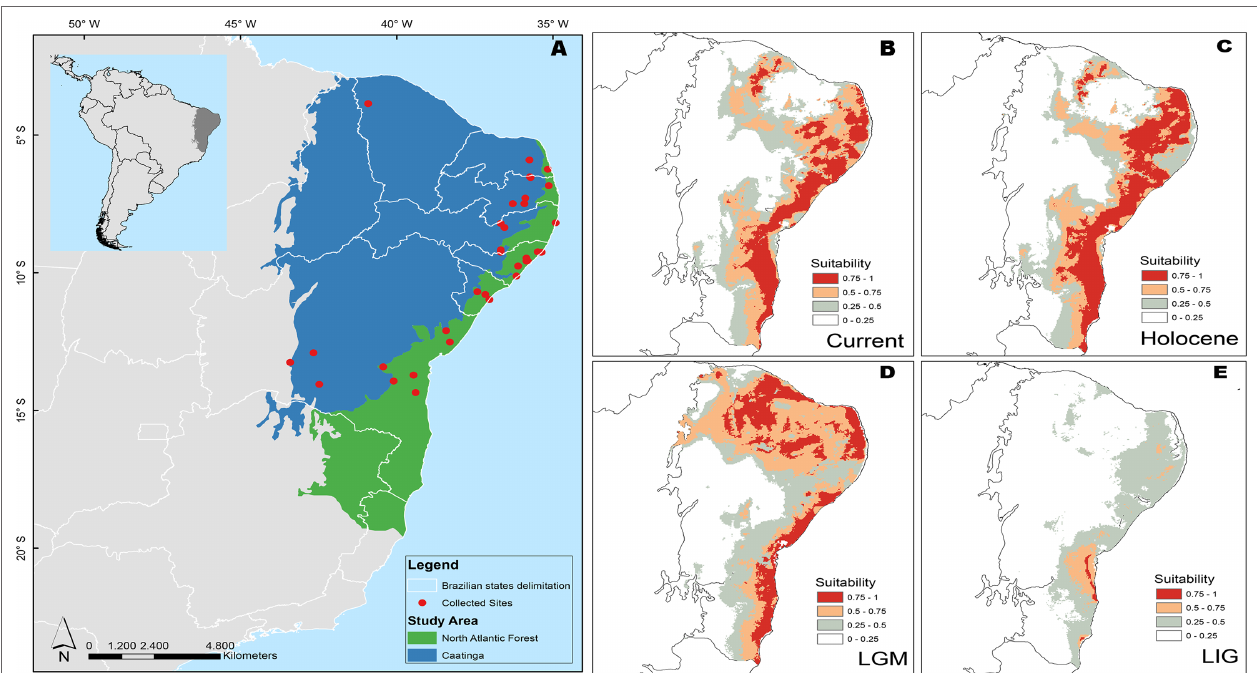
FIGURE 1 | Distribution of morphoclimatic domains and sampling localities in Brazil for specimens of P. nordestinus included in this study (A) and Ecological Niche Modeling (ENM) showing suitable areas for the P. nordestinus potential occurrence in present and past climate scenarios. ENM prediction for present day (B) , during 6 ka–mid-Holocene (HOL) (C) ; 21 ka–Last Glacial Maximum (LGM) (D) ; and 120 ka–Last Interglacial Maximum (LIG) (E) . See Material and Methods for more